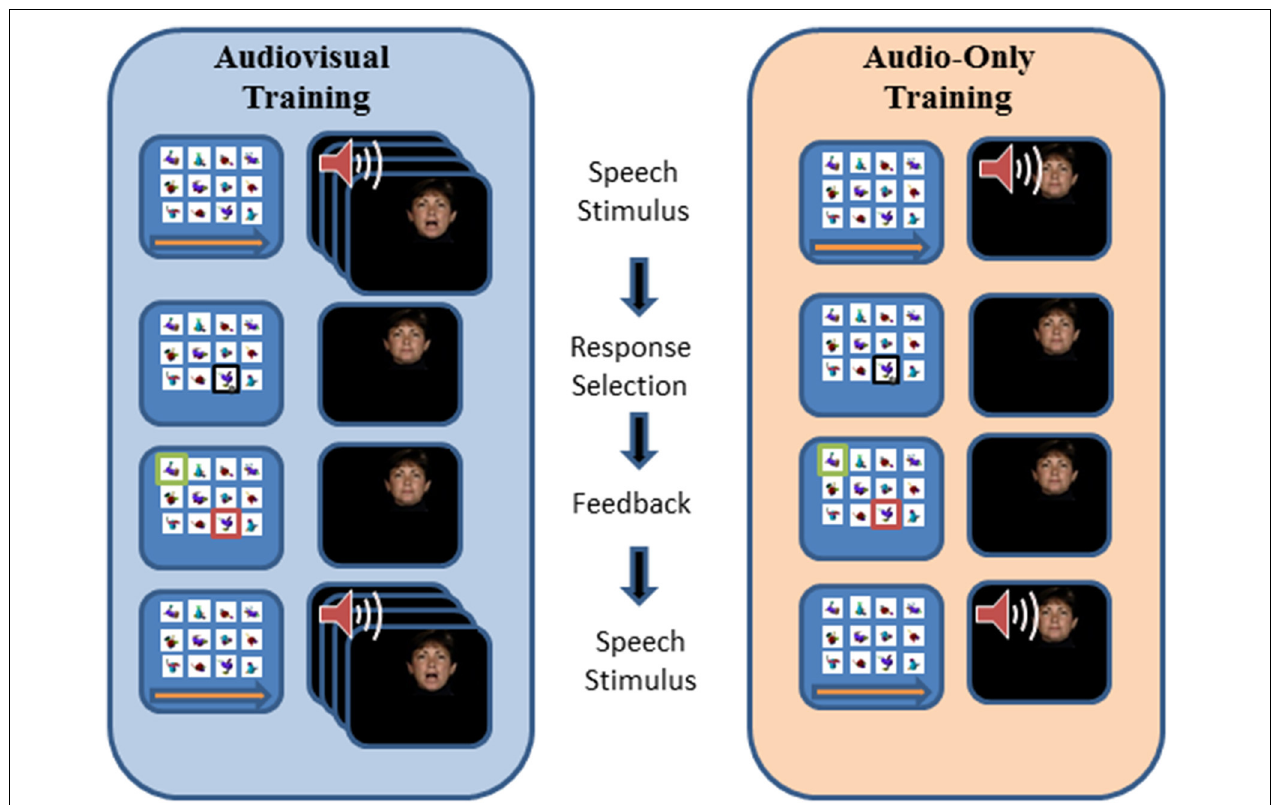
FIGURE 2 | Sequence of events during a paired-associates training trial with AV training (on the left) and AO (on the right) stimuli. A speech stimulus was presented, followed by the participant’s response selection, followed by feedback and a repetition of the speech stimulus. Each panel depicts the screen showing the fribble images side-by-side